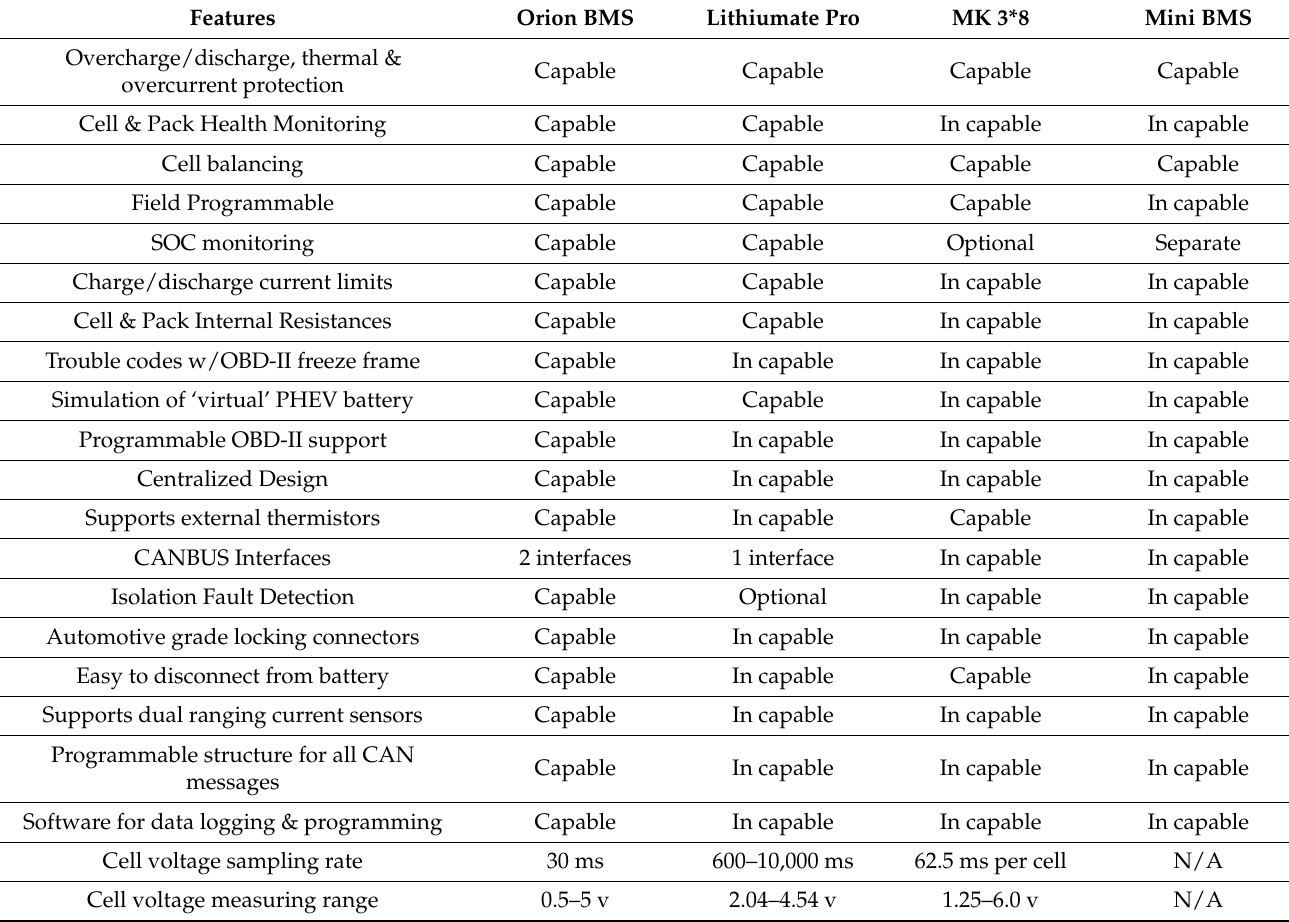
Table 6. Comparison between commercially available BMS